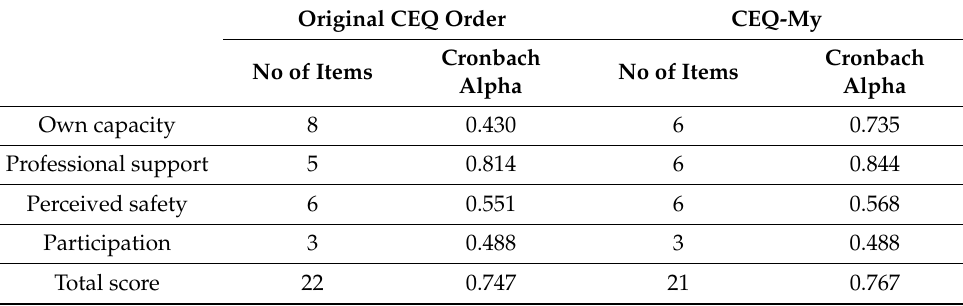
Table 5. Cronbach’s Alpha for the domains of CEQ-My and the overall